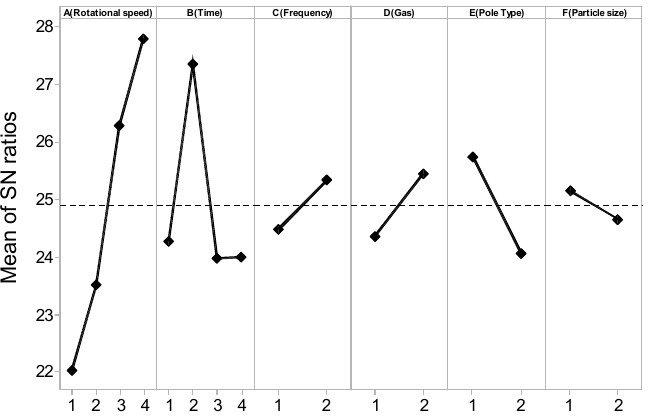
Figure 5. Main effects plot for the S/N ratios of machining surface roughness.